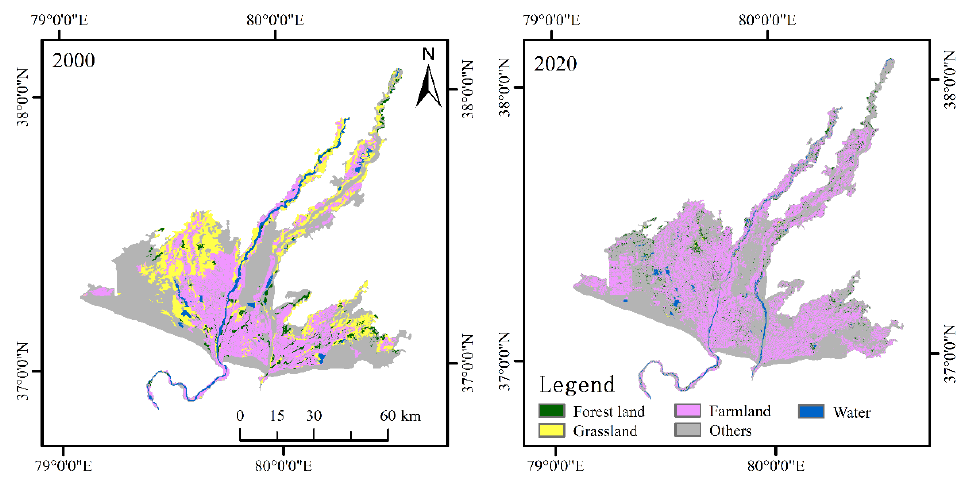
Figure 3. Temporal and spatial changes of land use in Hotan Oasis from 2000 to 2020.